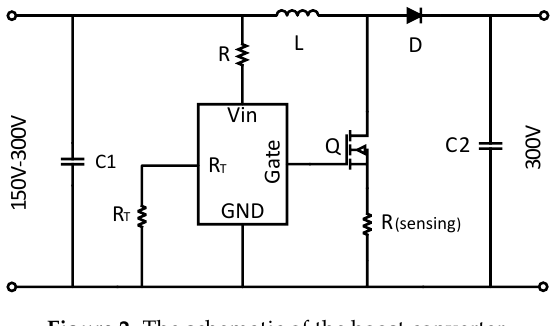
Figure 2. The schematic of the boost